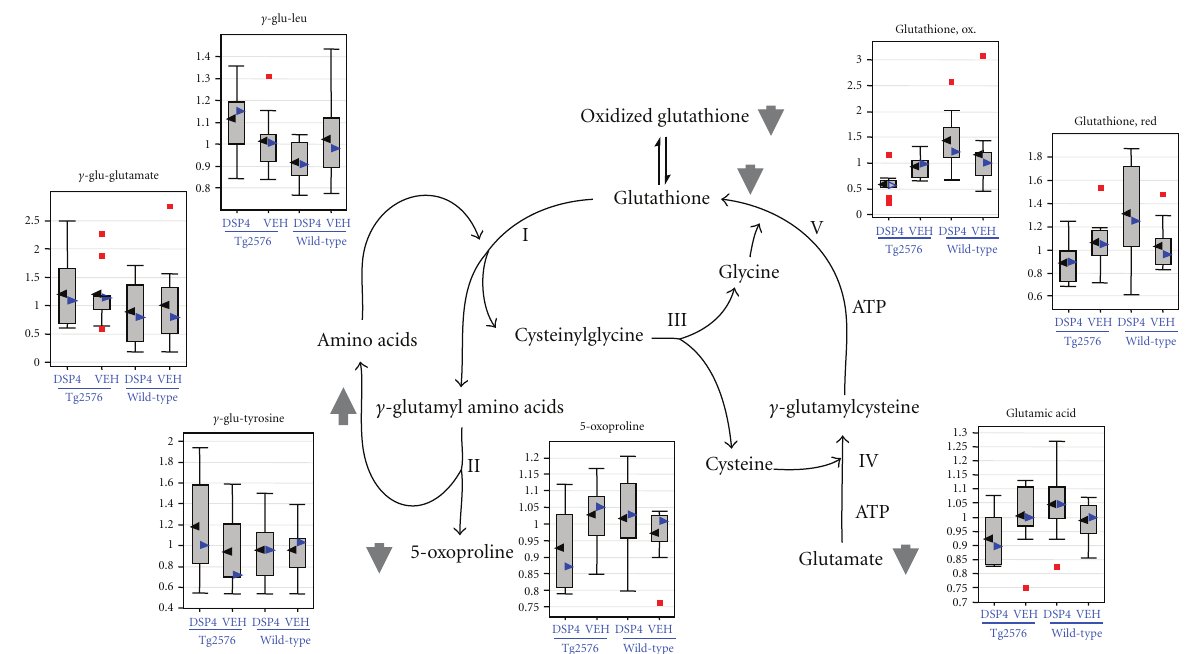
Figure 3: Glutathione metabolism. Glutathione metabolism and gamma-glutamyl-dipeptide formation are altered in the brains of the Tg2576 DSP4 group. For each metabolite, the distribution of values within each of the four cohorts is represented as a Whisker plot, with the relative normalized intensity as the abscissa. Mean values represented by the black arrowheads, median values by blue arrowheads. Detailed statistical comparisons of oxidized glutathione, reduced glutathione, and γ -glutamine-leucine are given in Table 1. Glutamic acid was omitted from the table even though the P -value for the comparison of ablated transgenics to ablated wild-types was .0109, the Q -value exceeded our threshold at a value of